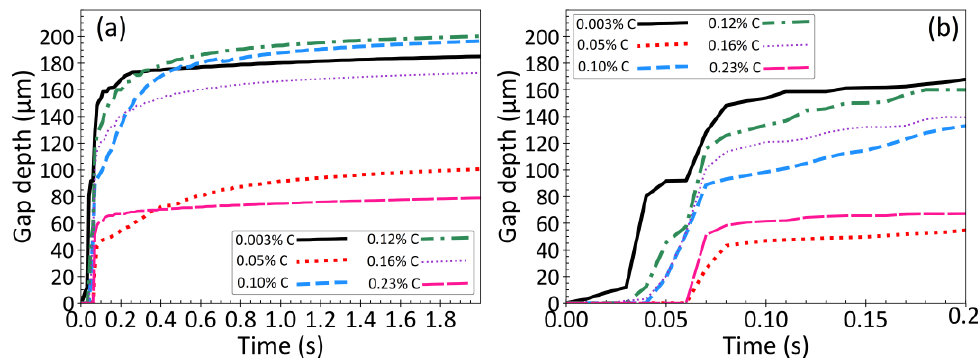
Figure 11. Gap depth evolution with time, with THF, for the six investigated steel grades, (a) for short times 0 - 2 s; (b) for very short times 0 - 0.2 s.